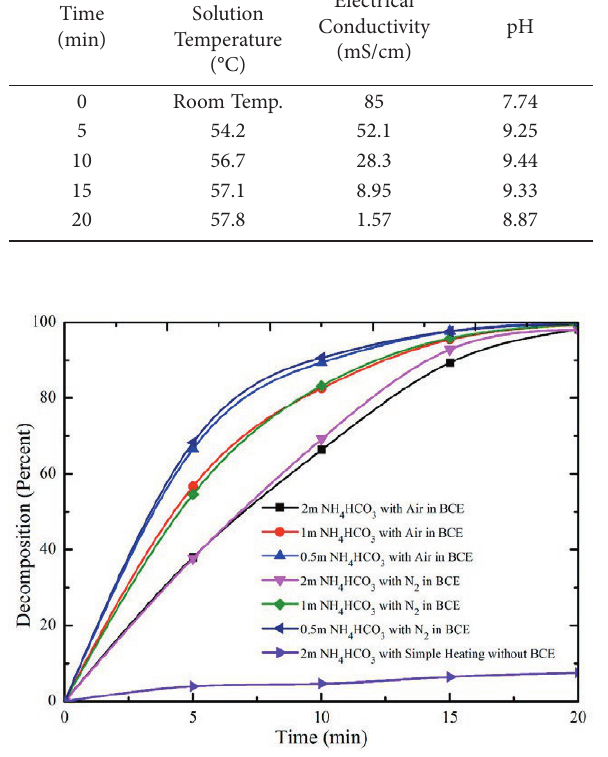
Figure 3. Percent decomposition of NH 4 HCO 3 solutions at different concentrations in the BCE with an inlet gas (air and nitrogen) tem- perature of 275 °C and column solution temperature of 57 °C and in a stirred vessel for simple heating at around 57